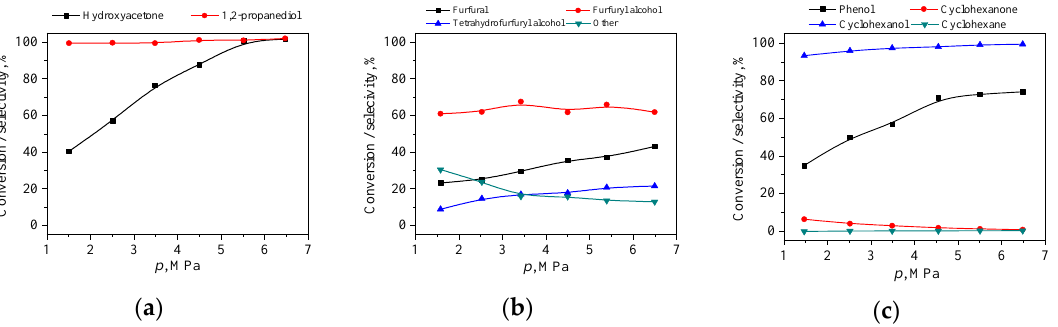
Figure 9. Effect of pressure on the conversion and product selectivity (( a ): hydroxyacetone, 150 °C, 1 h; ( b ): furfural, 150 °C, 1 h; ( c ): phenol, 150 °C, 1 h).